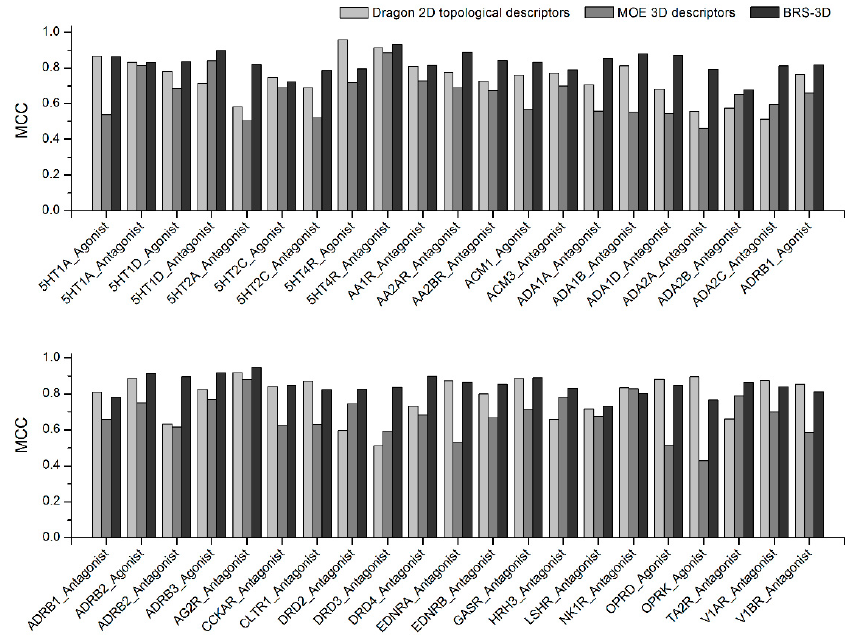
Figure 4. The MCC values of SVM models based on BRS-3D and other two state-of-the-art descriptors.